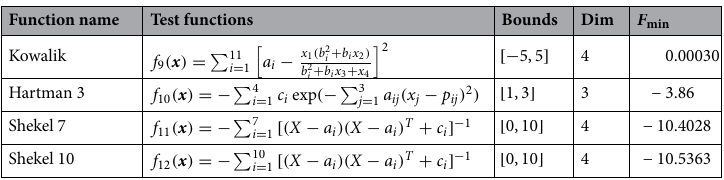
Table 3. Fixed-dimension multimodal benchmark functions.